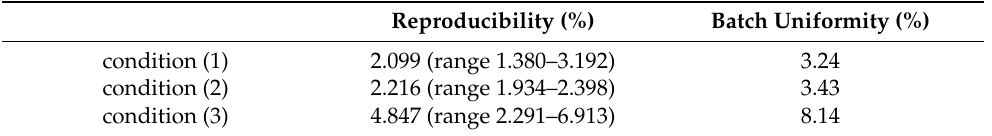
Table 2. Variations in sensitivity (reproducibility, batch